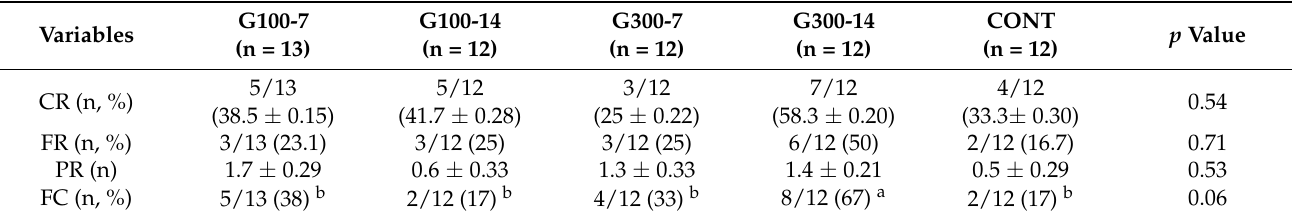
Table 2. Least-square means ± standard error for conception rate (CR), fertility rate (FR) prolificacy rate (PR), and fecundity rate (FC) according to the experimental treatment considering two doses of hCG (100 and 300 IU) and applied at two different times (7 and 14 d), and the Control group (CONT) after a fixed time artificial insemination protocol in multiracial, multiparous, and anovulatory goats (n = 61, Alpine, Saanen, Nubian x Criollo) managed under extensive conditions in Northern Mexico (April, 25 ◦